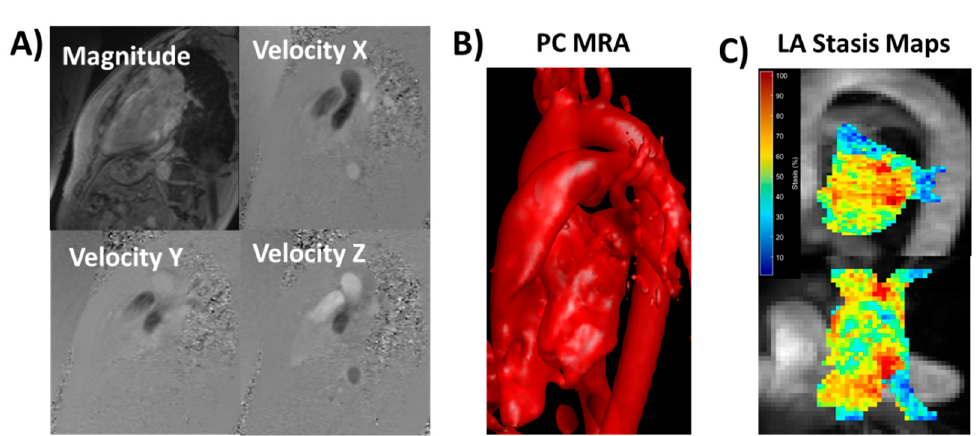
Figure 1. Data processing and analysis workflow. Panel ( A ) shows an example of corrected 4D-flow images. Panel ( B ) illustrates a time-average phase-contrast (PC) magnetic resonance angiogram (MRA) with an optimal threshold for visu- alizing left atrial (LA) anatomy. The LA was manually segmented using slice-by-slice, isolating the LA volume. Panel ( C ) shows the calculated LA stasis maps within the LA volume using a sagittal and a top-view maximum intensity projection. Red areas represent high stasis; blue areas represent low